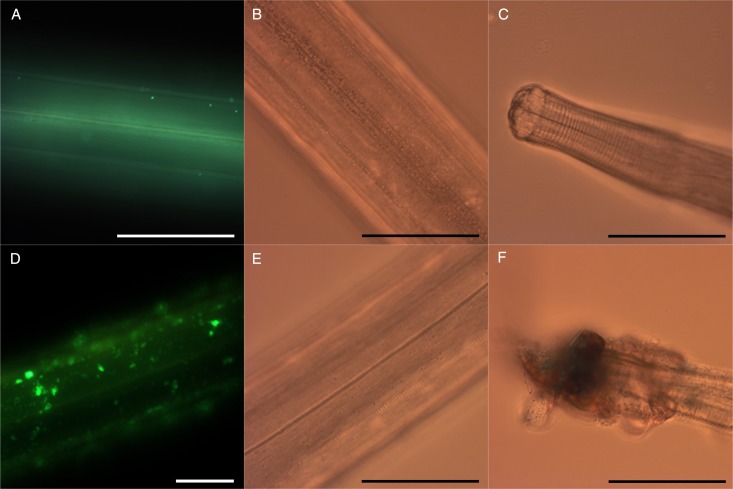
Micrographs of Cooperia oncophora adults pre-incubated for 5 days at 38 °C in control media (A, B, C) or CT fraction from blackcurrant leaves at 300 µg mL−1 (D, E, F), and then transferred to control media containing fluorescent E. coli for 24 h. The cuticle is shown by fluorescent microscopy (A, D) or light microscopy (B, E) and of the anterior part is illustrated in (C, F) (scale bars = 100 µm).